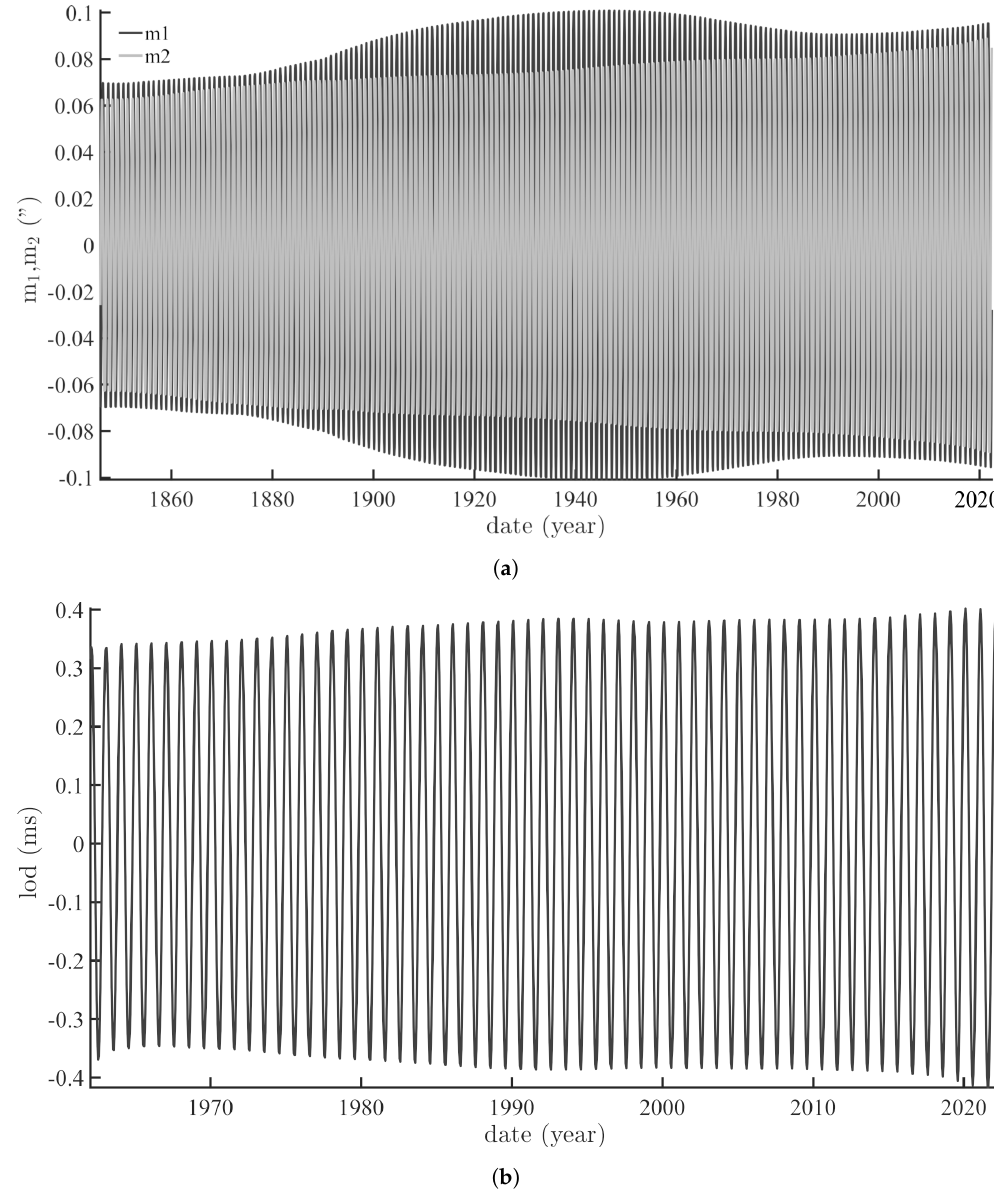
Figure 4. Annual components extracted from pole path and lod . ( a ) The annual couple ( m 1 , m 2 ) of polar motion coordinates extracted by iSSA . ( b ) The annual component of lod extracted by iSSA